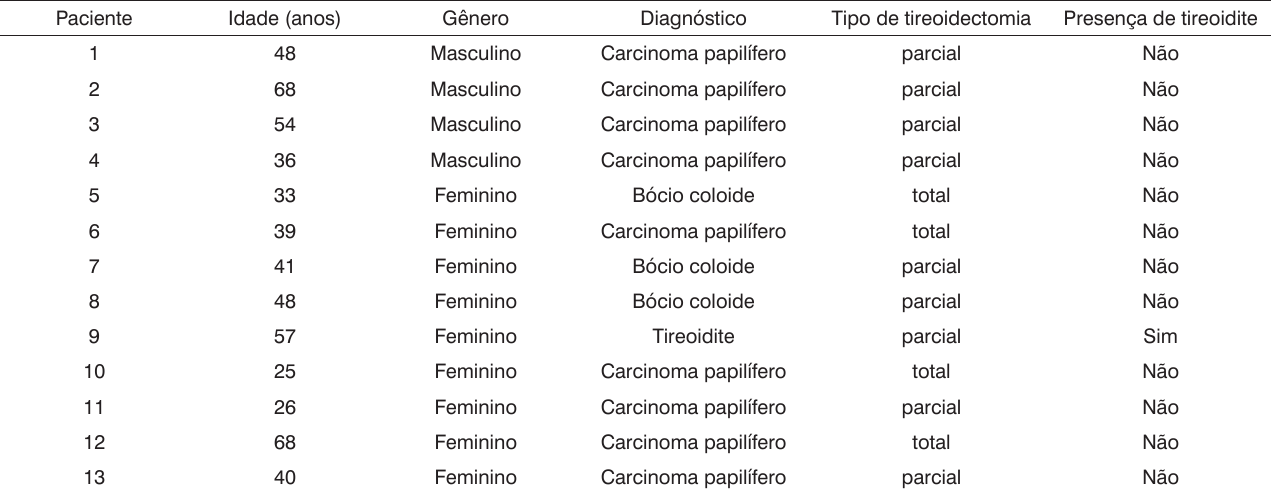
Tabela 3. Descrição dos casos de paratireoidectomia acidental.